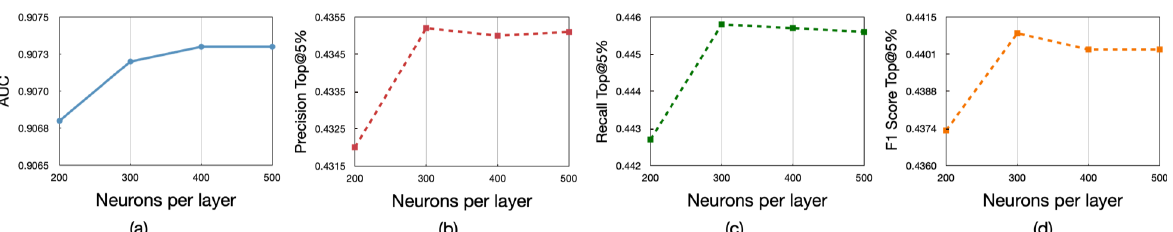
Fig. 5 Performance with respect to the number of hidden layers.